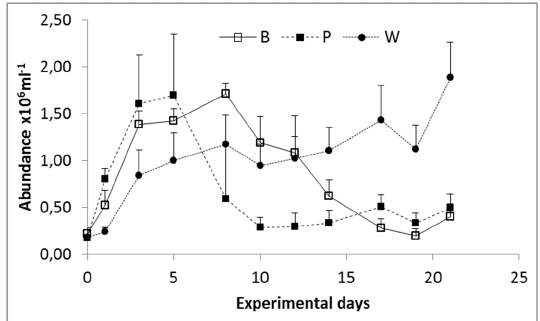
Figure 1. Prokaryoplankton abundance during the experiment. Letters indicate the site of origin of the inoculum. B: Banyuls, P: Pagasitikos, W: Woods Hole.